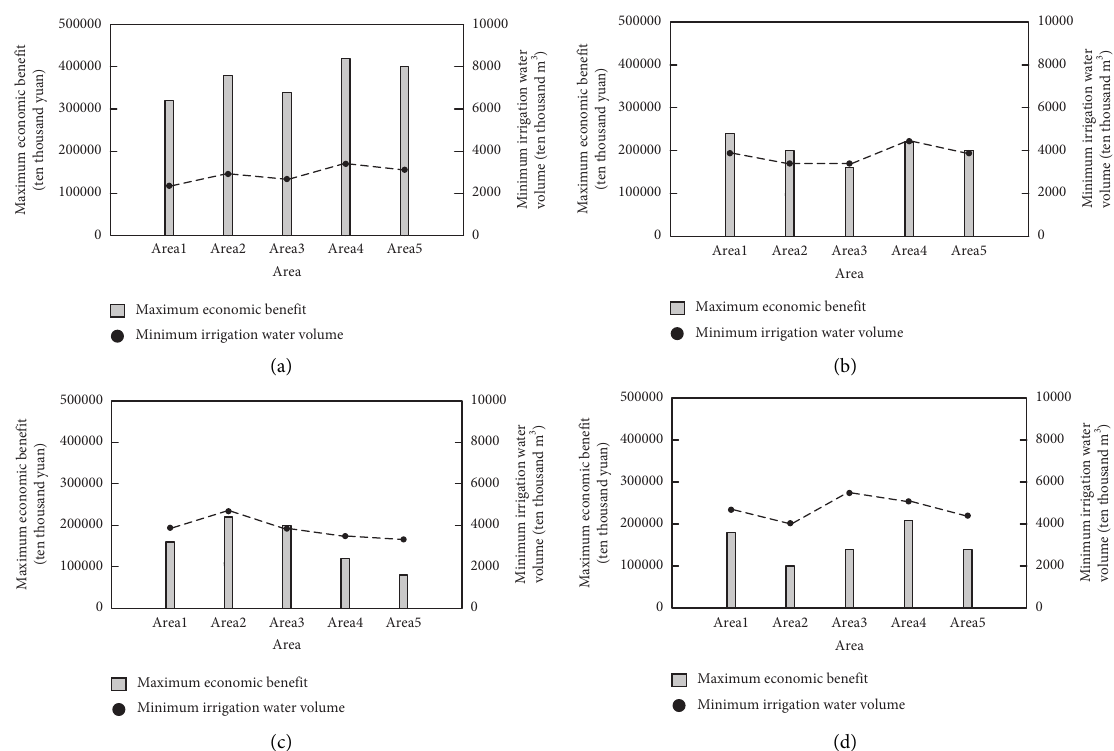
Figure 3: Maximum economic benefit and minimum irrigation water quantity by different algorithms. (a) The maximum economic benefit and minimum irrigation water quantity of algorithm-1, (b) the maximum economic benefit and minimum irrigation water quantity of algorithm-2, (c) the maximum economic benefit and minimum irrigation water quantity of algorithm-3, and (d) the maximum economic benefit and minimum irrigation water quantity of algorithm-4.